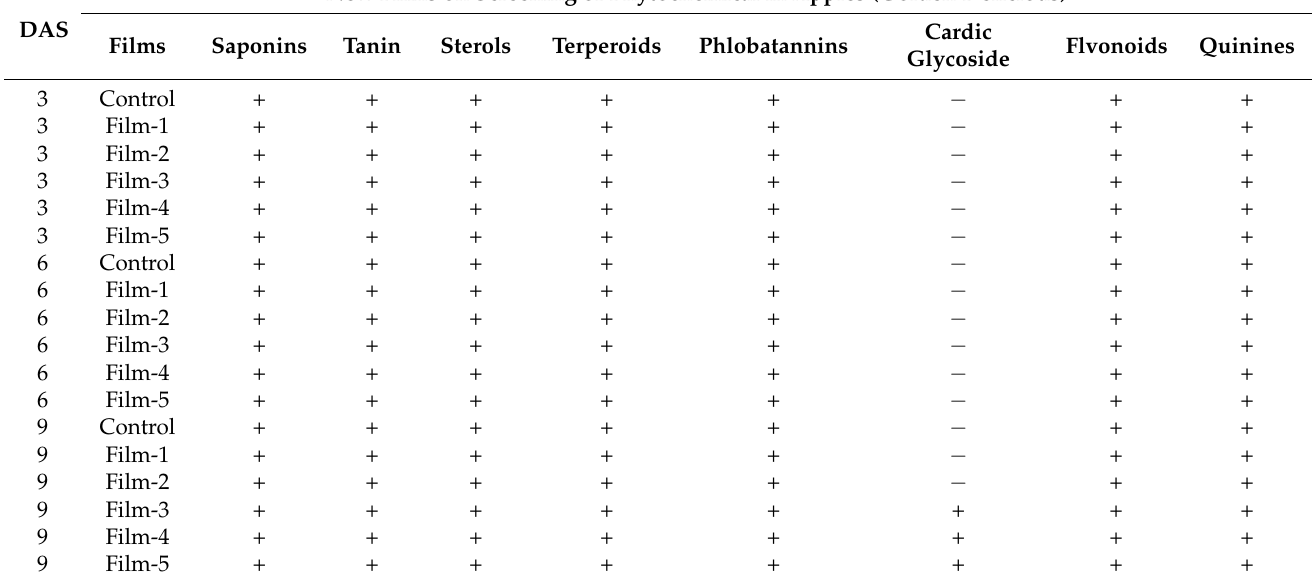
Table 7. Qualitative screening of phytochemical screening in apples (Golden